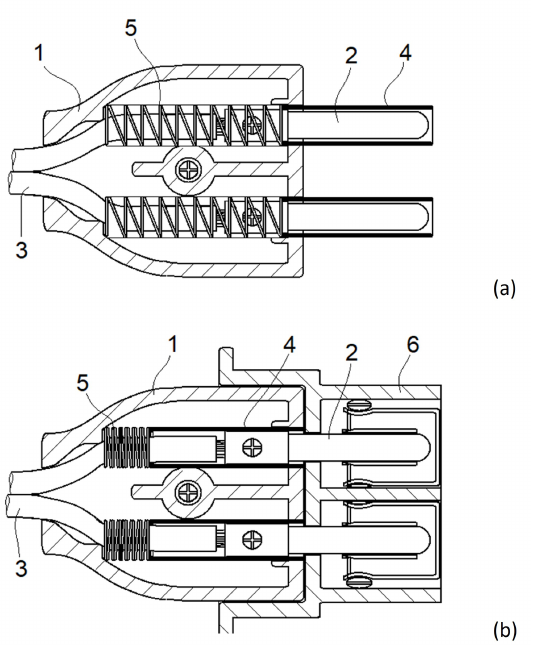
Figure 1. The utility model ( a ) represents a male plug when not connected. ( b ) represents the previous plug when inserted and connected to a base